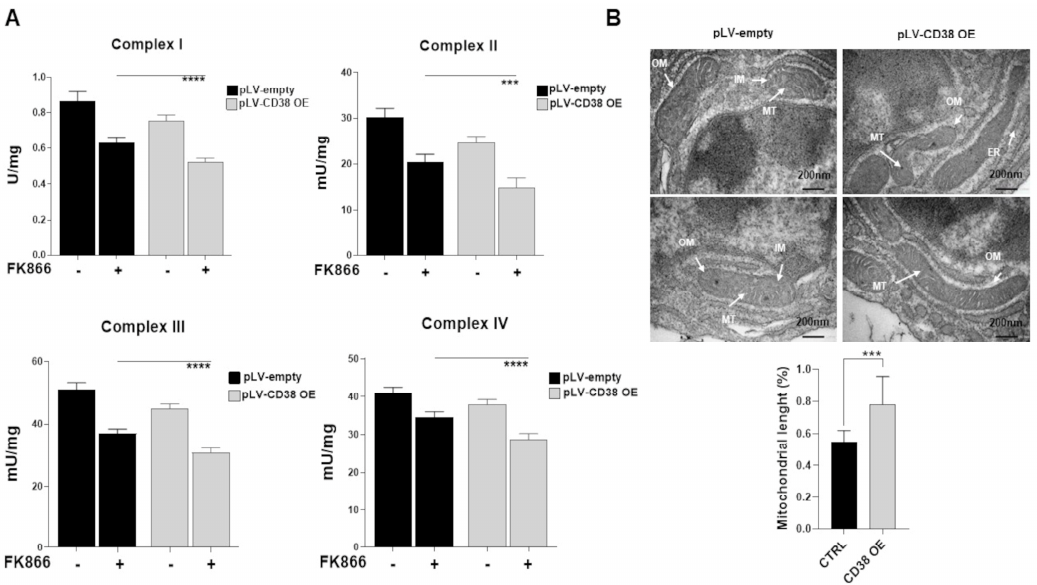
Figure 7. Mitochondrial dynamic shift underlies an organelle-specific dysfunction triggered by CD38 upregulation . ( A ) Mitochondrial complexes (I, II, III, IV) activities were measured in H929 control and CD38 OE cells at baseline and following treatment with FK866 (2 nM). ( B ) TEM image of H929 control and CD38 OE cells displaying elongated mitochondria. Scale bars: 200 nm. Average mitochondrial length quantified in μ m. Data are presented as mean ± S.D ( n = 3). (*** p ≤ 0.001, **** p ≤ 0.0001; unpaired t -test) .